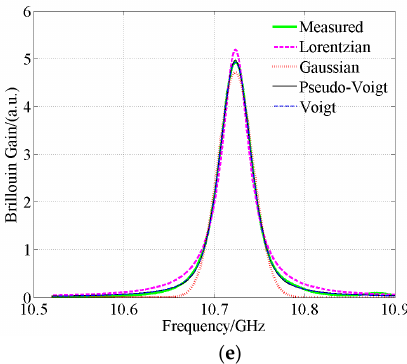
Figure 7. Waveshapes fitted by different models for spectra with different pulse widths, measured signals with average number of 2 18 . ( a ) 10 ns; ( b ) 20 ns; ( c ) 50 ns; ( d ) 100 ns; ( e ) 200 ns. Table 7. Mean value of the key parameters, E and T by different models for spectra with different pulse widths, measured signals with average number of 2 18